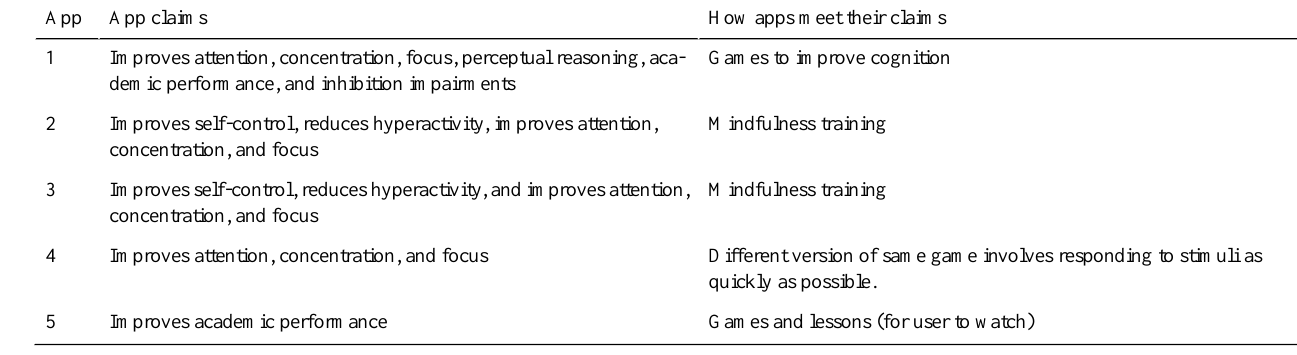
Table 1. Characteristics of the apps downloaded from iTunes.